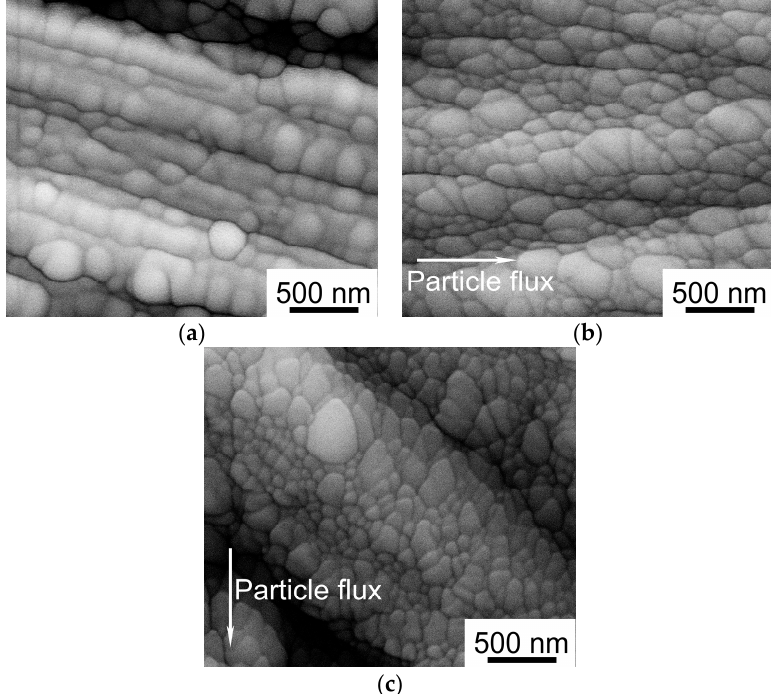
Figure 3. Calcium phosphate (CaP) coatings deposited on Ti at a working gas pressure of 0.8 mTorr under tilt angles of 0° ( a ), 60° ( b ), and 80° ( c ).